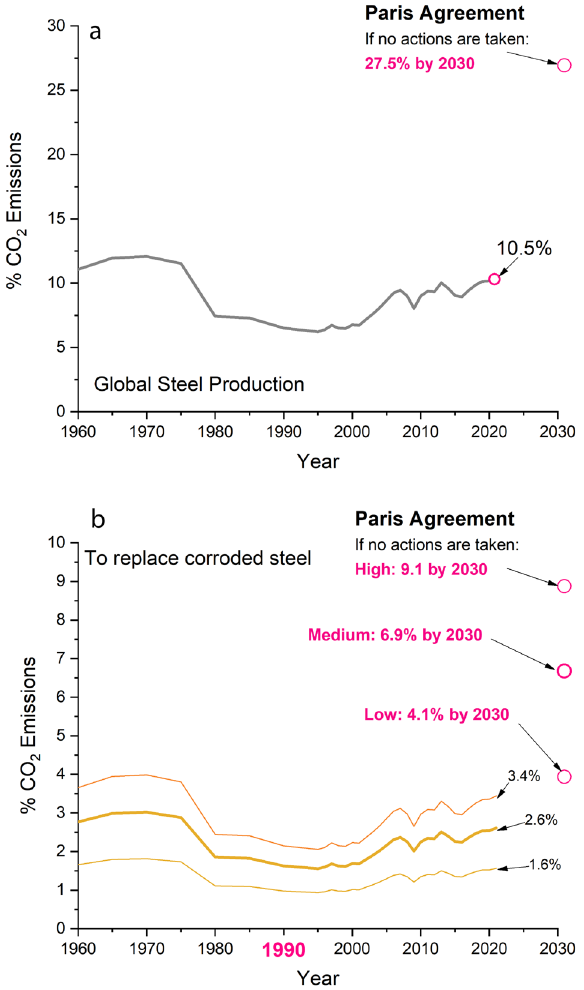
Fig. 2 CO2 emissions produced by the steel industry and those destined to replaced corroded steel compared with the 2030 Paris Agreement target. CO 2 emissions produced by the steel industry as a percentage of the global CO 2 emissions (%CO 2 ) ( a ) and %CO 2 emissions produced to replace corroded steel ( b ). The year 1990 is highlighted as it is the bases of the EU target